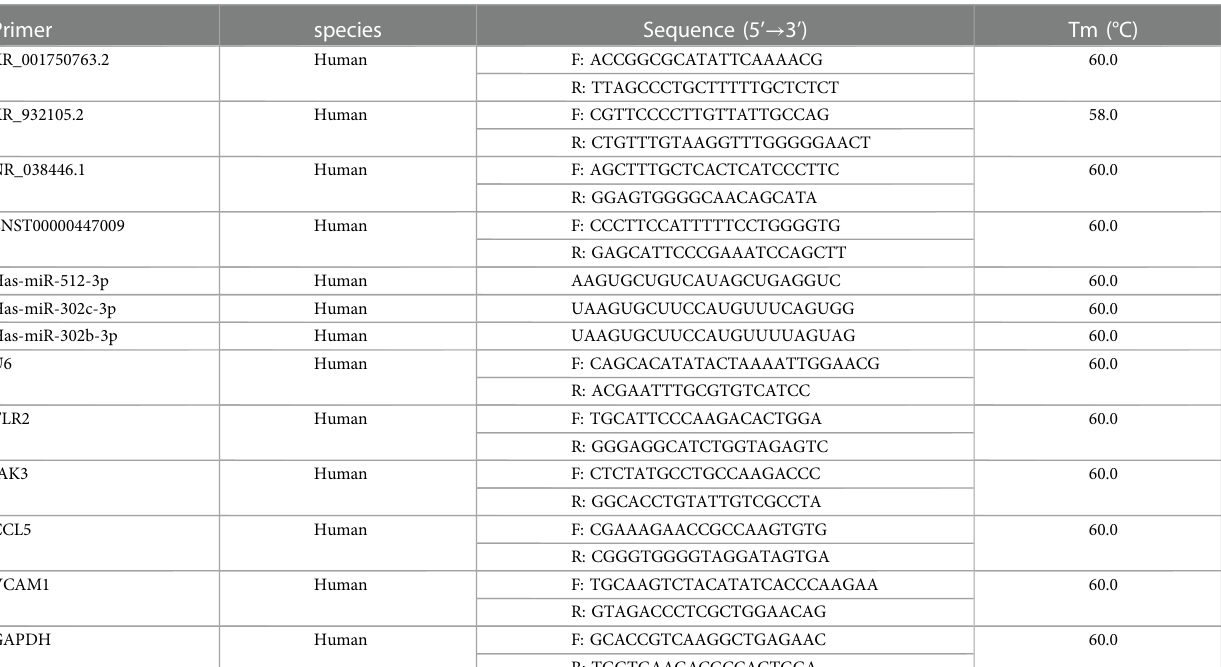
TABLE 1 Primers used in the present study.